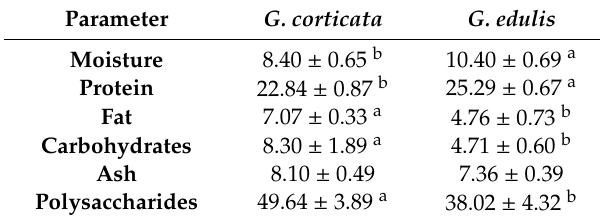
Table 1. Proximate composition (g / 100 g dry weight seaweed) G. corticata and G. edulis